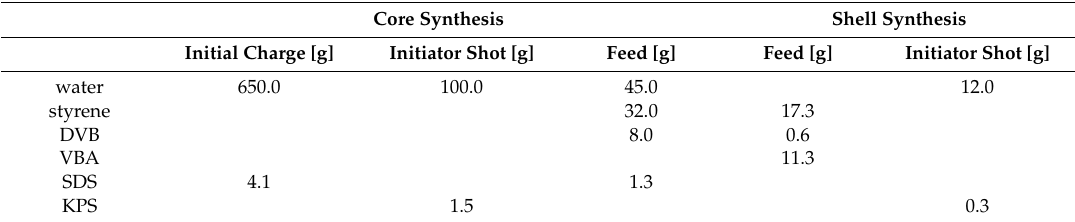
Table 1. Recipe for the latex synthesis of produced polymer